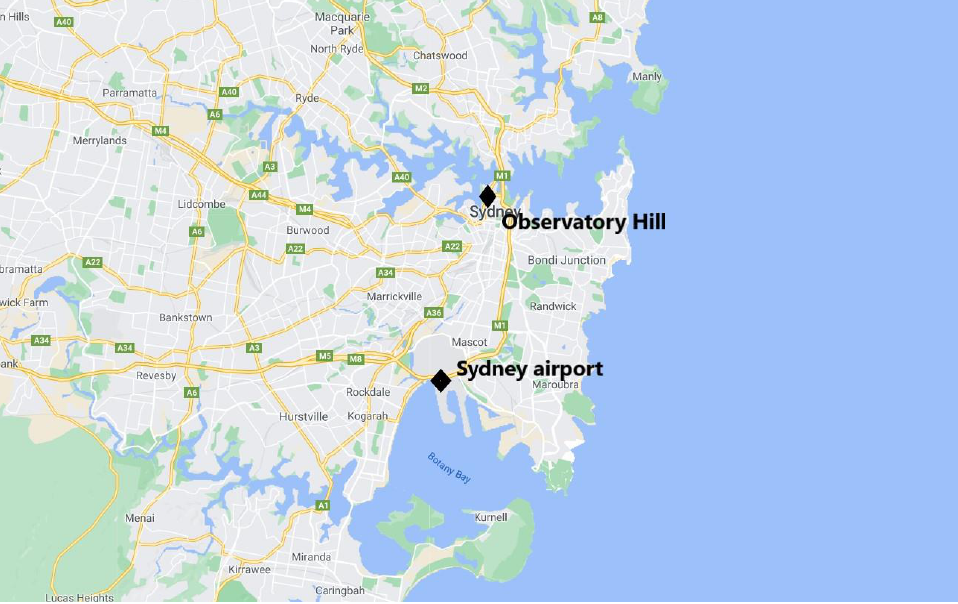
Figure 1. Map of two meteorological stations at the city of Sydney.